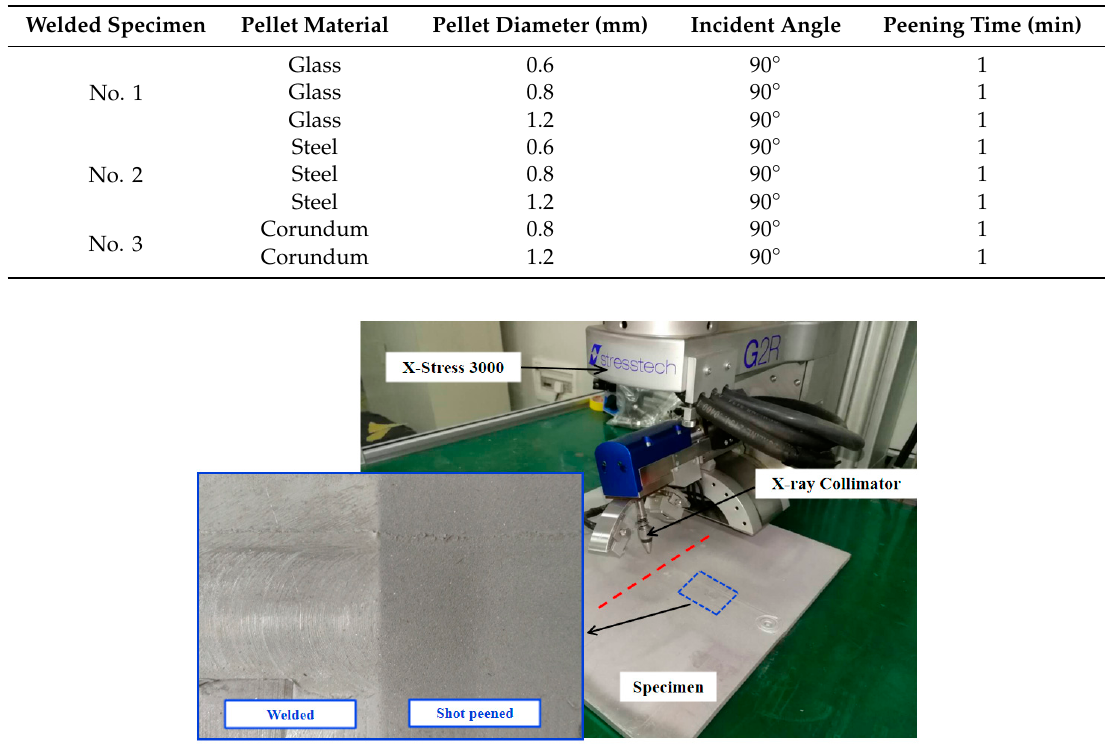
Table 3. Shot peening process parameters.